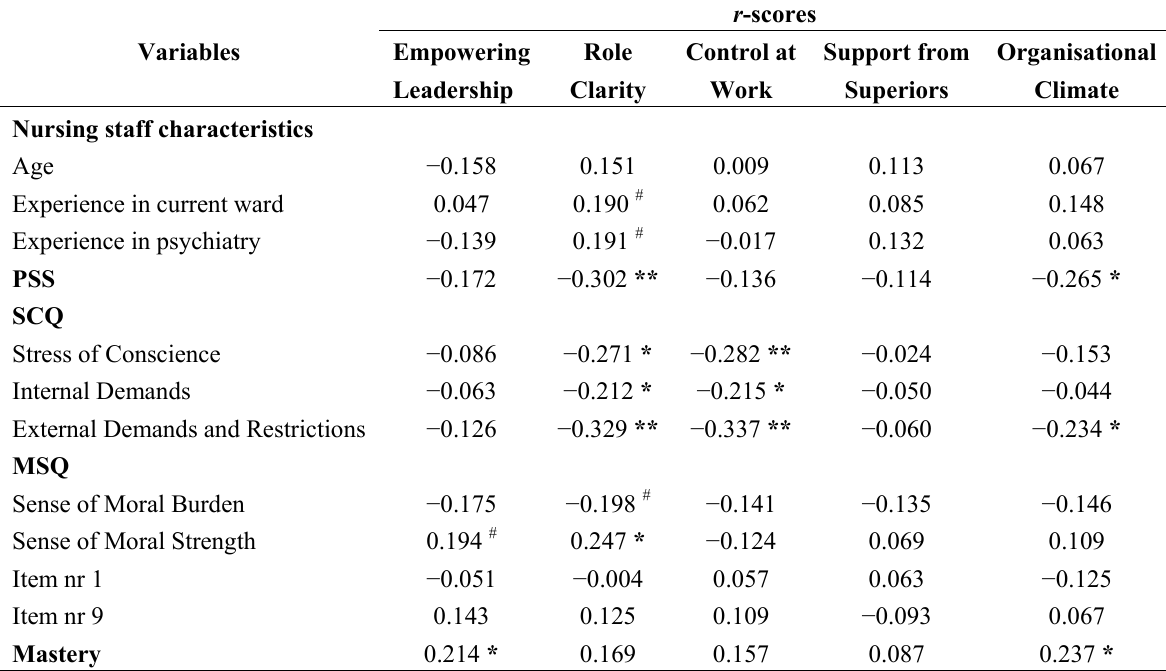
Table 2. Correlations among psychosocial work environment (QPSNordic 34+), nursing staff characteristics variables, Perceived Stress Scale (PSS), Stress of Conscience (SCQ), Moral Sensitivity Questionnaire (MSQ), and Mastery scale.